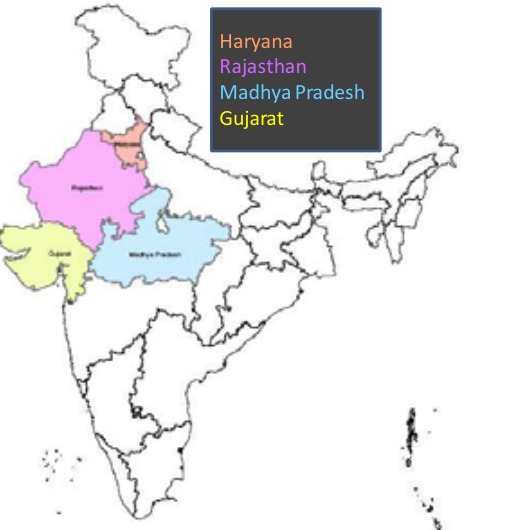
Table 2: Calibration coefficients of AWiFS used for computing radiance values L NIR is radiance value for NIR (Near Infra Red) band and L R is radiance value for red band. The range of NDVI values varies from -1.0 to +1.0. For simplicity; it was scaled in the range of 0 to 200 by multiplying 100 and adding 100. Scaled NDVI =100 + 100 x (NDVI) The NDVI images of all dates were stacked together in time sequence to form time-series dataset of NDVI images. Figure 3 shows multi-date AWiFS data over Haryana state.